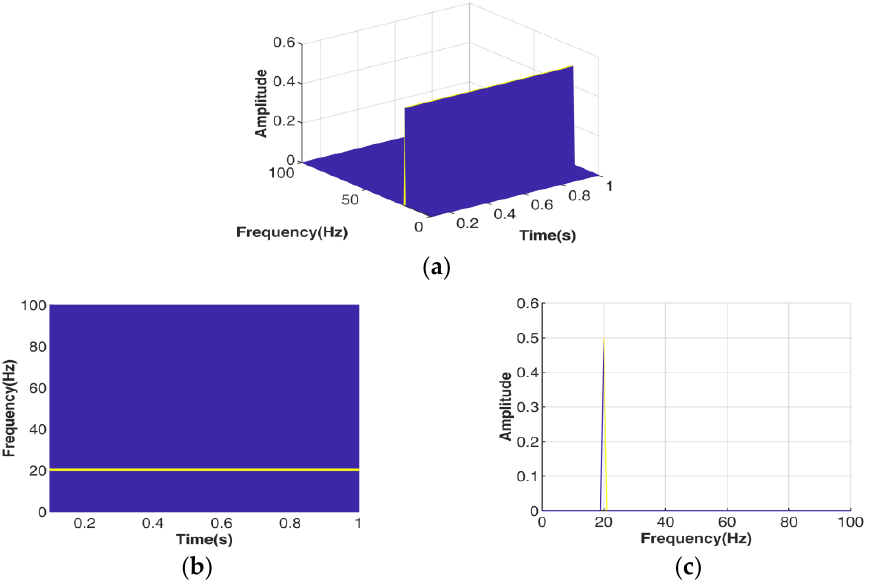
Figure 4. Time-frequency analysis of harmonic signal SEST process. ( a ) SEST three-dimensional representation; ( b ) SEST time-frequency representation; ( c ) SEST frequency spectrum.